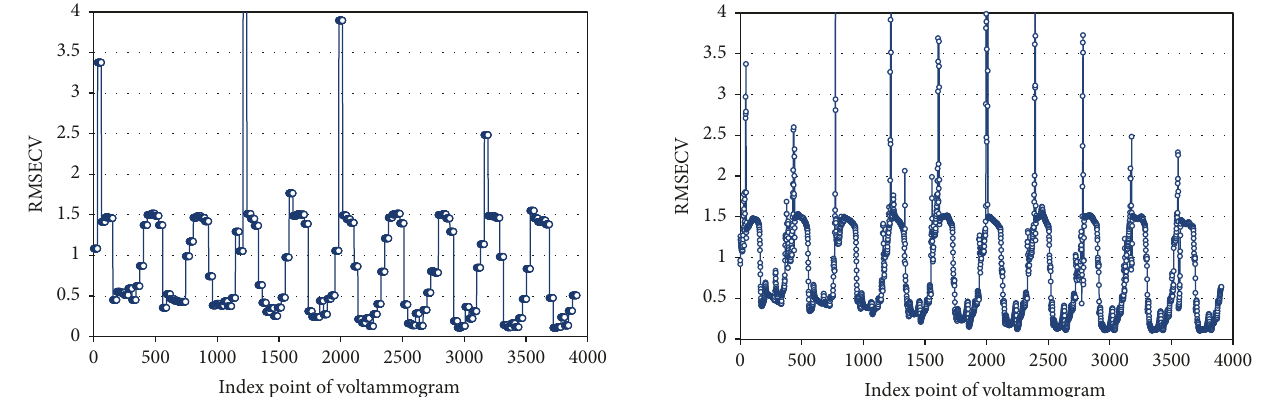
Figure 8: RMSECV calculated with MWPCR for a moving one- step-at-a-time interval of 31 points of mean centered voltammo- grams for 𝐹 = 1